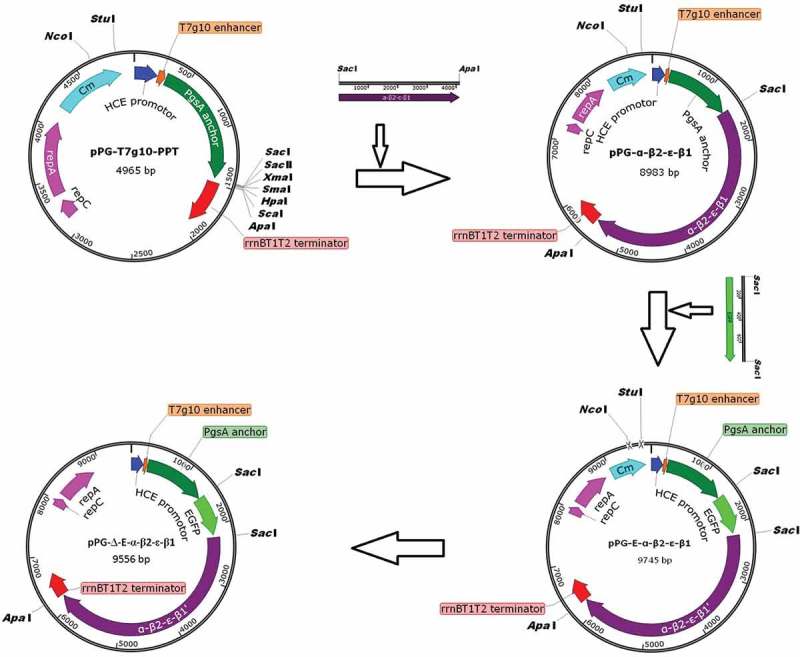
Construction process of the recombinant pPG-Δ-E-α-β2-ϵ-β1 plasmid. The constitutive expression plasmid pPG-T7g10-PPT contains a HCE strong constitutive promoter, a T7g10 transcriptional enhancer, a PgsA anchor from Bacillus subtilis, and an rrnBT1T2 terminator.